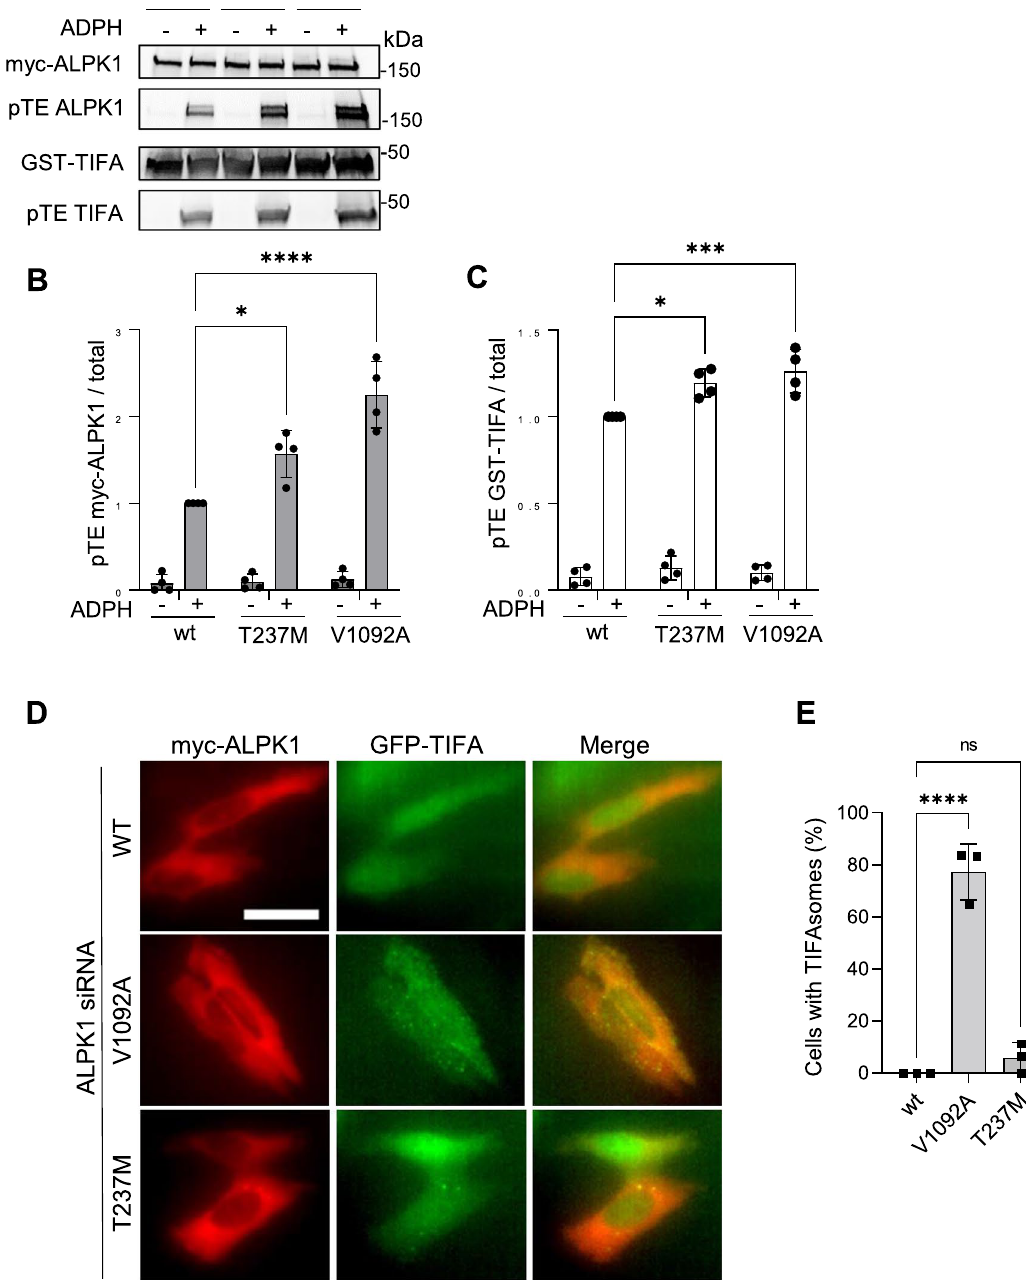
Figure 5. Disease-associated ALPK1 mutants have altered kinase activity. ( A ) Disease-associated mutants have altered myc-ALPK1 and GST-TIFA thiophosphorylation. HEK293 cells transfected with wt or indicated mutated myc-hALPK1 constructs and treated or not with ADPH. ALPK1 kinase activity was then assessed using the newly described protein thiophosphorylation-based assay. ( B ) Quantification of myc-hALPK1 thiophosphorylation as shown in ( A ). ( C ) Quantification of GST-TIFA thiophosphorylation as shown in ( A ). ( D ) V1092A mutant induces constitutive assembly of TIFAsomes. GFP-TIFA-expressing Hela cells were depleted of endogenous ALPK1 by siRNA and transfected with wt, T237M and V1092A myc-tagged hALPK1 constructs. After 12 h of transfection, cells were fixed without ADPH treatment and stained for myc. TIFA is in green, myc-ALPK1 in red. Bar is 30 μm. ( E ) Quantification of cells with TIFAsomes. For each construct, n > 150 cells expressing a myc-hALPK1 construct were selected and the fraction of cells with TIFAsomes was quantified. Data correspond to the mean ± SD of 4 ( B , C ) or 3 ( E ) independent experiments. Statistical significance was assessed using two ‐ way ANOVA followed by Tukey’s multiple comparisons ( B , C ) or one ‐ way ANOVA followed by Dunnett’s multiple comparisons test ( E